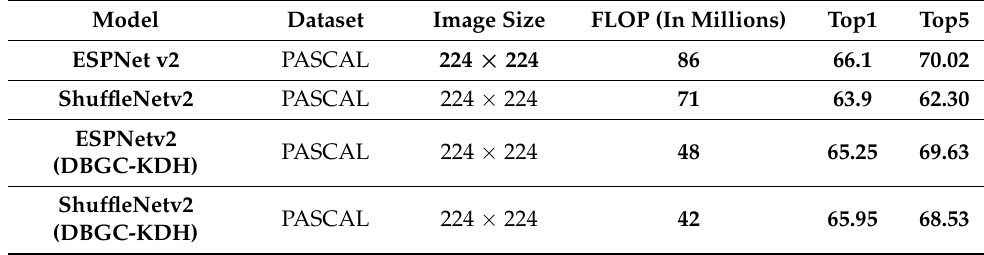
Table 7. Depth+height-based kernel. Table 7. Depth + height-based